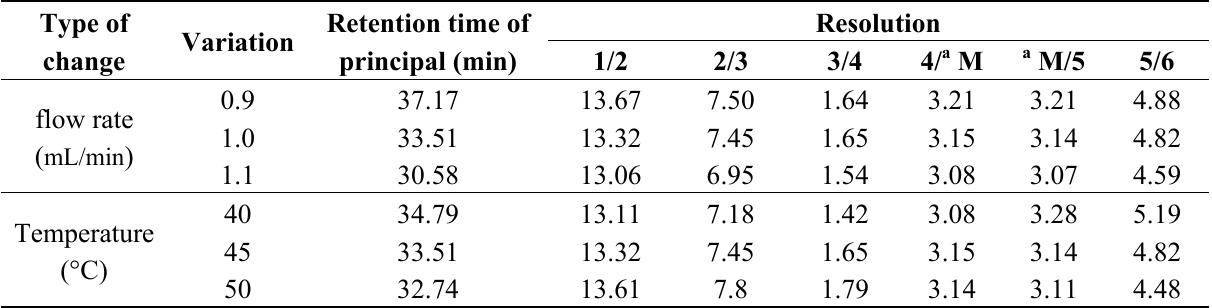
Table 5. Robustness